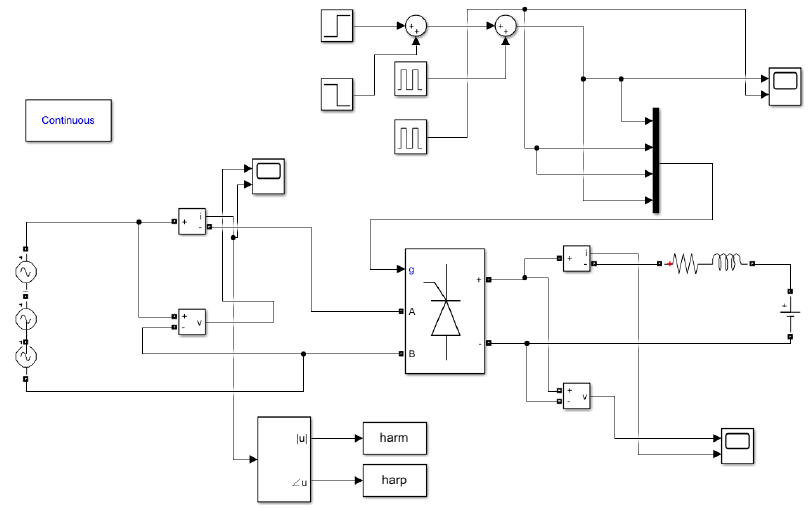
Figure 2. Circuit topology in Matlab/Simulink simulation.